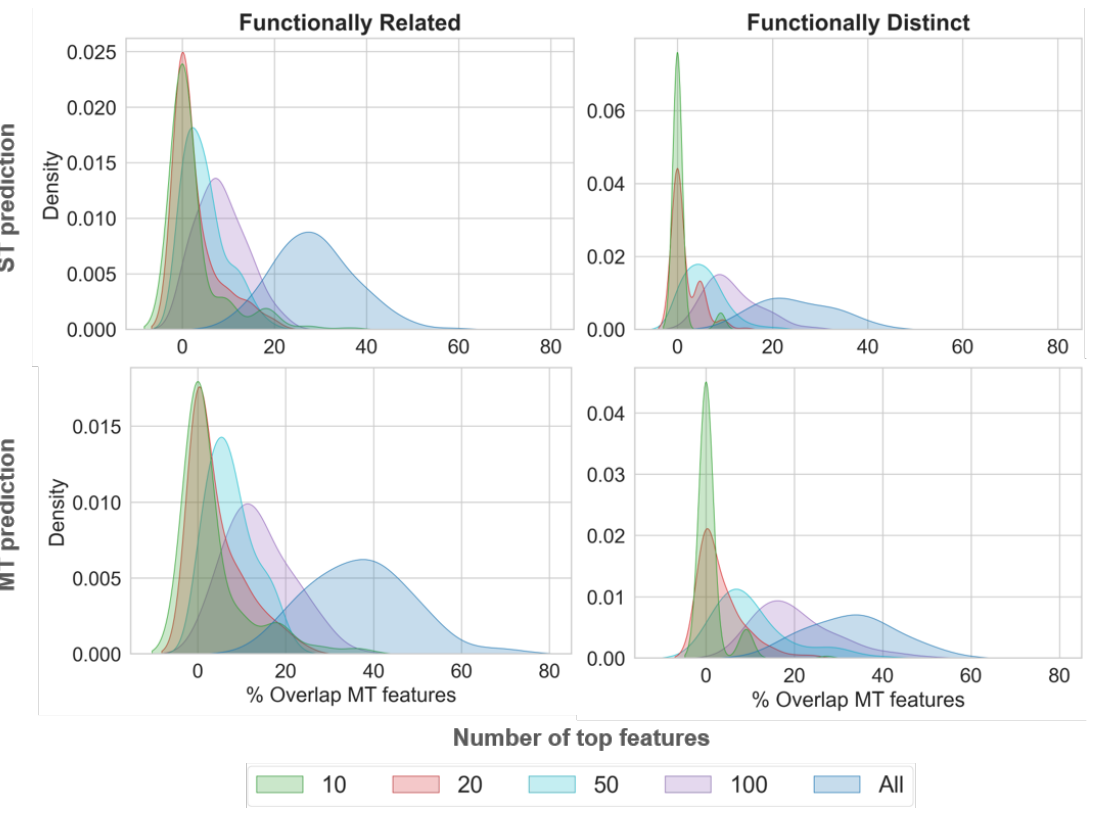
Figure 3. Feature overlap. Density plots show the overlap of feature sets of MT-CPDs, correctly predicted by the MT model, with feature sets of ST-CPDs, correctly predicted by the ST model (top) and MT-CPDs, correctly predicted by the ST model (bottom) for increasing numbers of top-ranked features. Feature overlap was calculated over all independent trials for related or distinct target pairs.